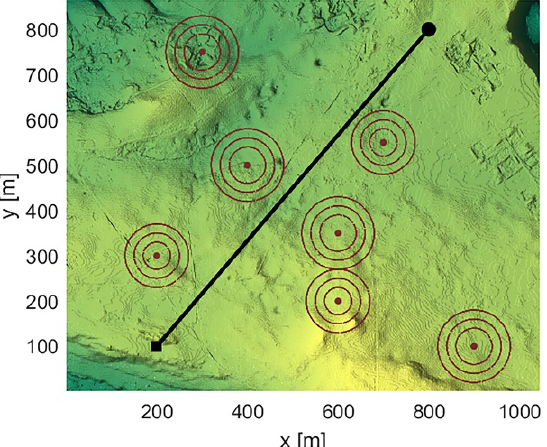
Figure 18. The average value of fitness functions for different environments.